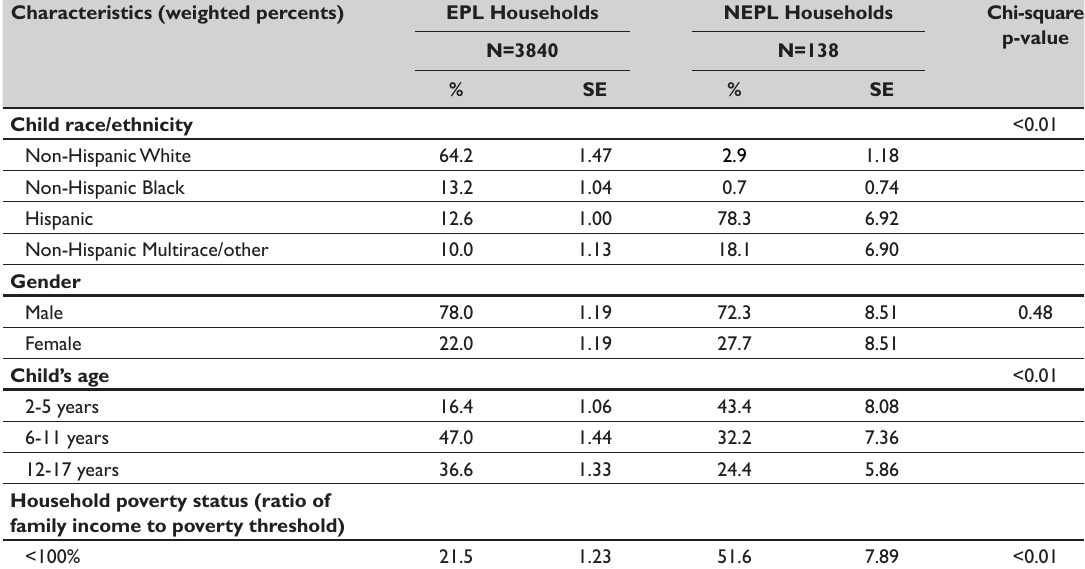
Table 1. Socioeconomic and Demographic Characteristics of Children with Autism Spectrum Disorders (ASD), Aged 2-17 Years in English Primary Language and Non-English Primary Language Households in United States Characteristics (weighted percents) EPL Households NEPL